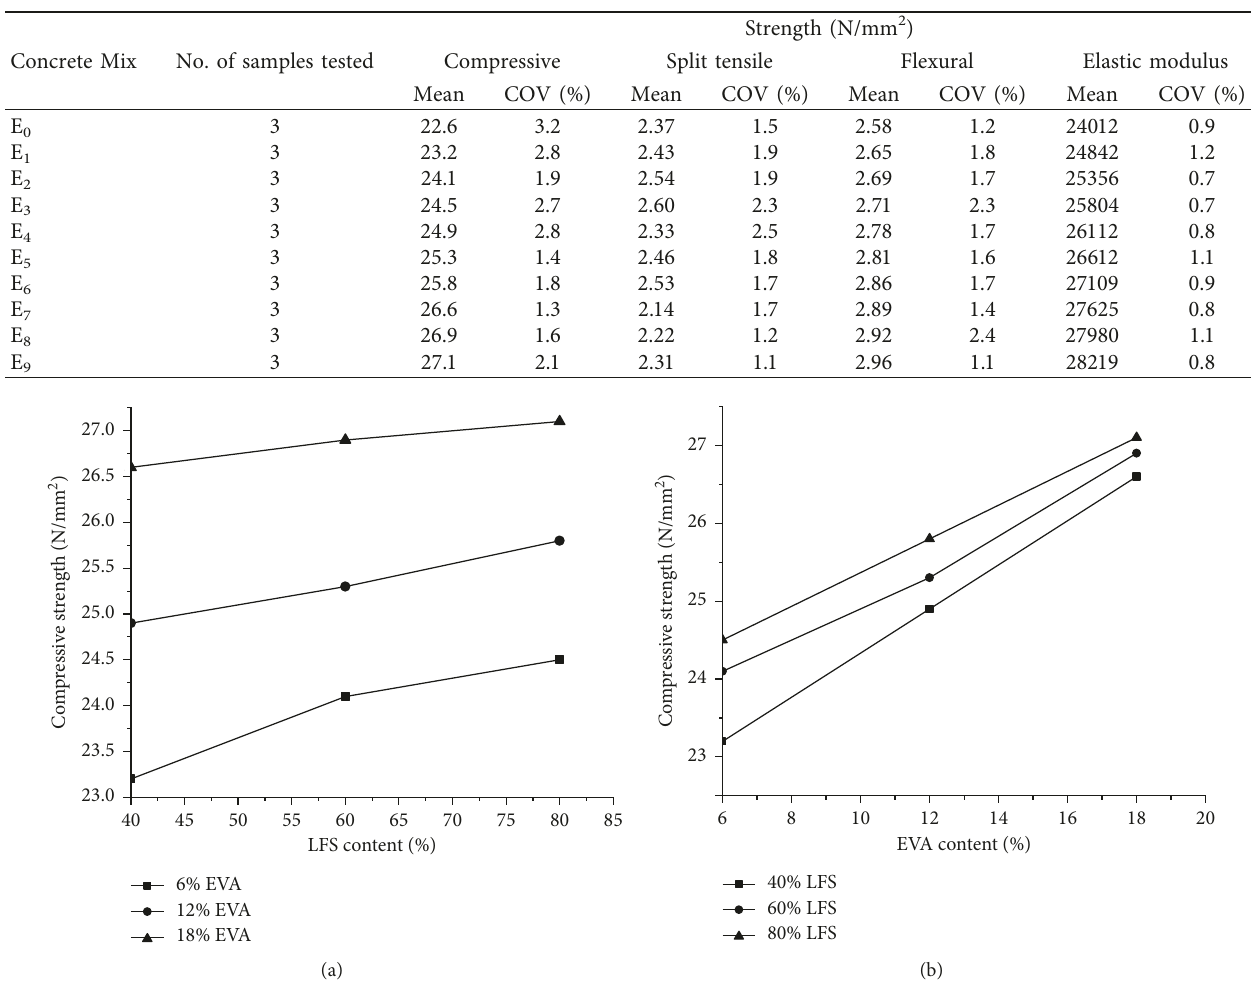
Table 9: Hardened properties of SCC.